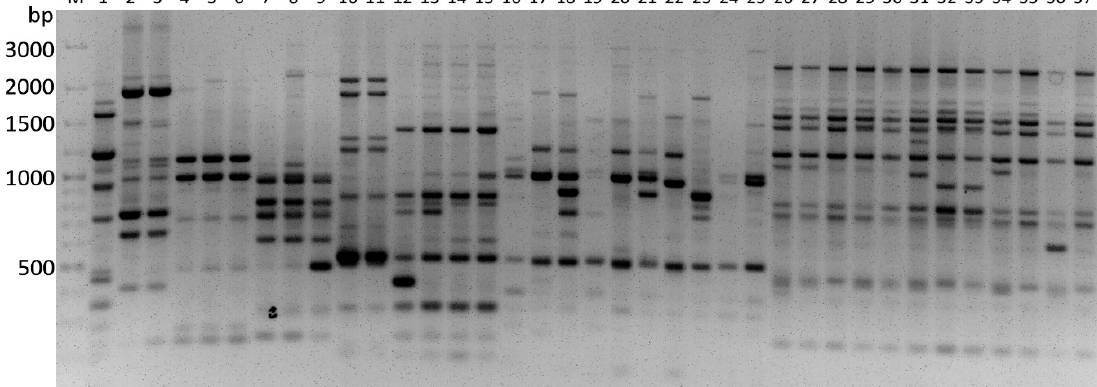
Figure 2. The band profiles with PBS primer (2395) for entomopathogenic fungal isolates. M: GeneRuler 100 bp Plus DNA Ladder (Thermo Fisher Scientific, Waltham, MA, USA). 1: Cordyceps farinosa ,